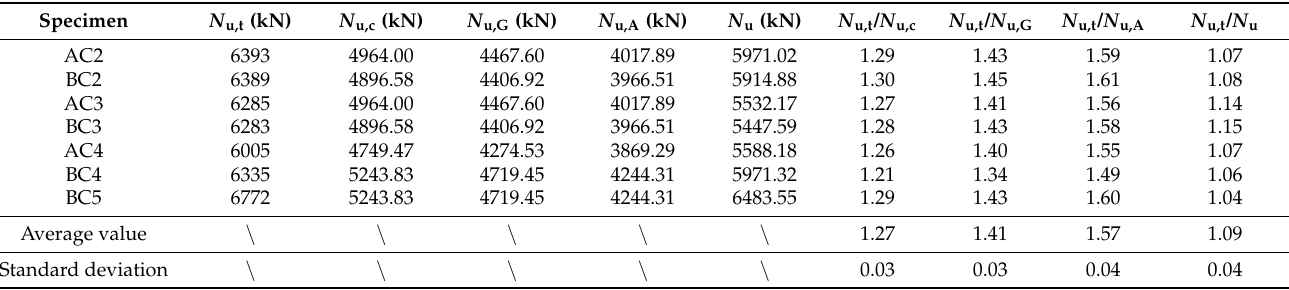
Table 5. Comparison of axial compression